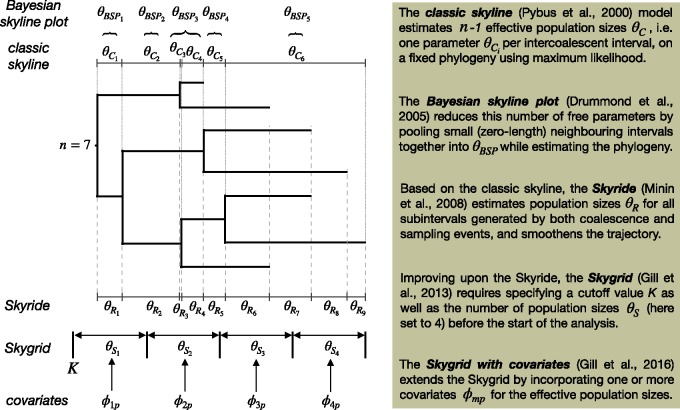
Conceptual representation of various nonparametric coalescent models on a phylogeny of n = 7 heterochronous sequences. The classic skyline (Pybus et al. 2000) and its extension, the generalized skyline (Strimmer and Pybus 2001), were the first among a still increasing collection of nonparametric coalescent models. Initially estimated using maximum likelihood inference on a fixed phylogeny, these models have been extended for use in Bayesian framework while accommodating phylogenetic uncertainty (Drummond et al. 2005). Recent developments include the Skyride (Minin et al. 2008), the Skygrid (Gill et al. 2013), and its extension to incorporate covariates (Gill et al. 2016), which all employ smoothing priors.